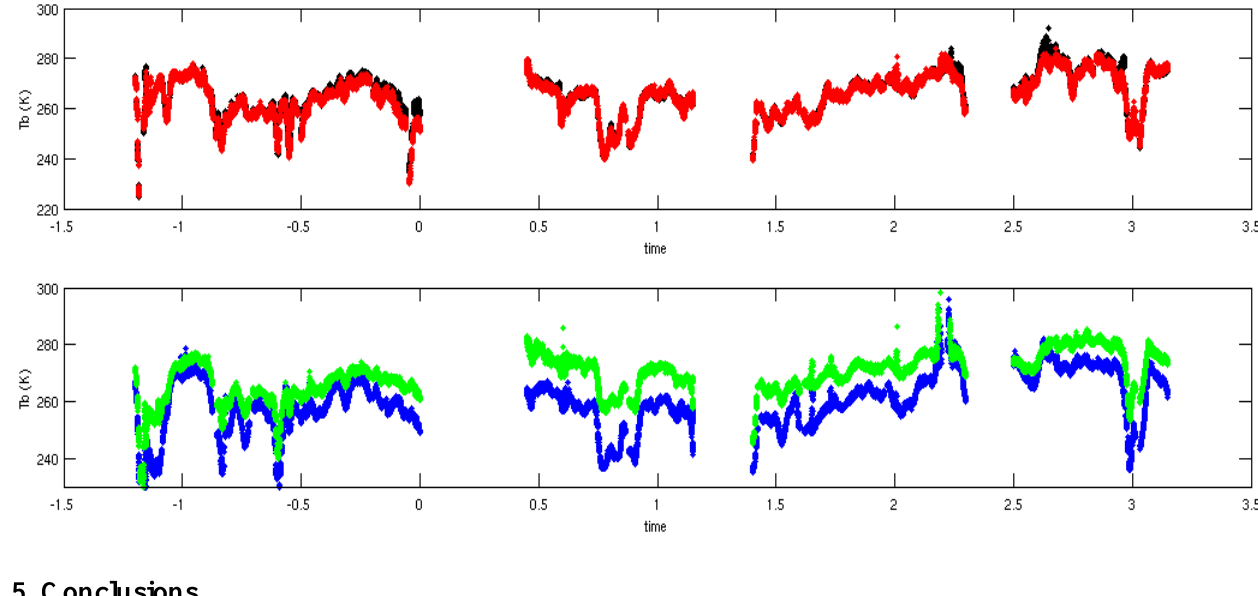
Figure 15. Time variations of Tb during the SMOSMANIA transect, in 2009, for the nadir antenna (upper figure, red and black lines respectively for the X and Y polarizations), and slant antenna (lower figure, green and blue lines respectively for the X and Y polarizations). A mixed Kurtosis and thresholds to the Tb standard deviation algorithm [25] was applied for the data used